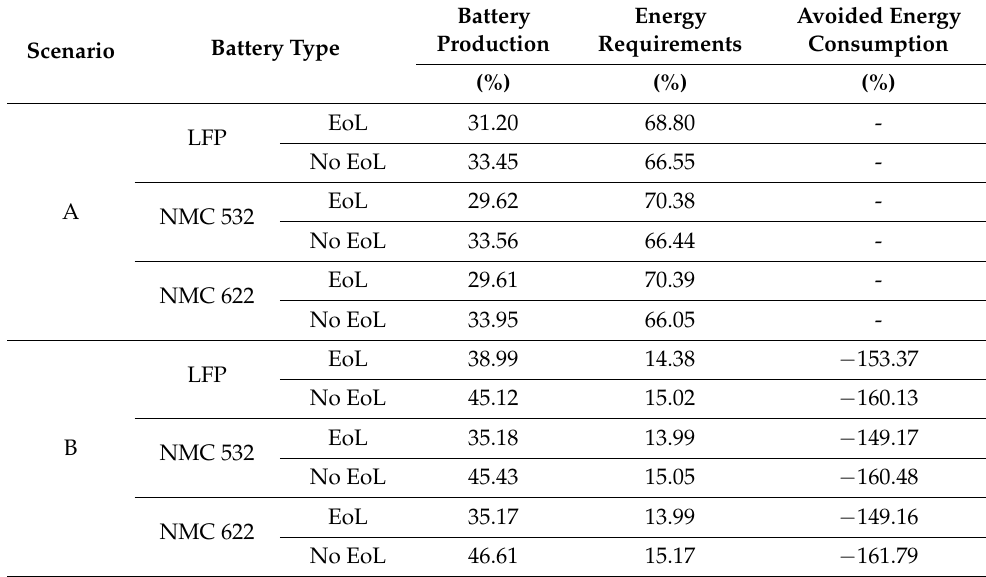
Table 10. Life cycle environmental results for the impact category of climate change (kg CO 2 eq) presented by the different processes during the use phase. Data are reported for 1 kWh of energy stored and delivered. Battery Scenario Battery Type